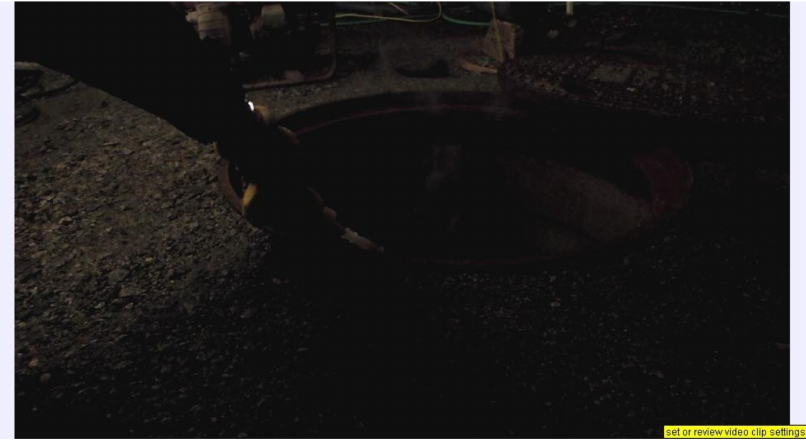
Figure 8. Emission of puffs of “smoke” from an open manhole soon after removing the cover. The smoke appears as a white coloration of the internal atmosphere in the center of the manhole.